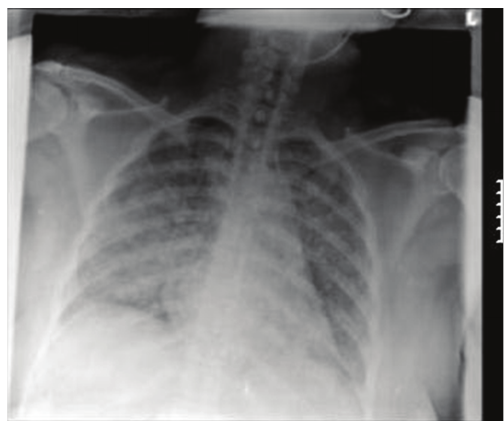
Figure 1: Chest radiograph on admission showing bilateral inter- stitial disease with alveolar filling (worse on the right side).